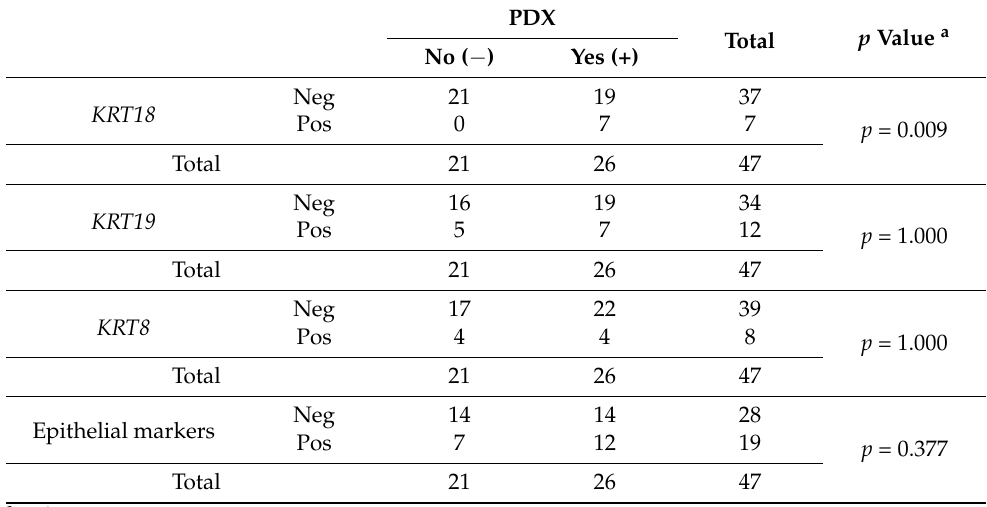
Table 2. CTCs expressing epithelial markers and the grafting efficiency.